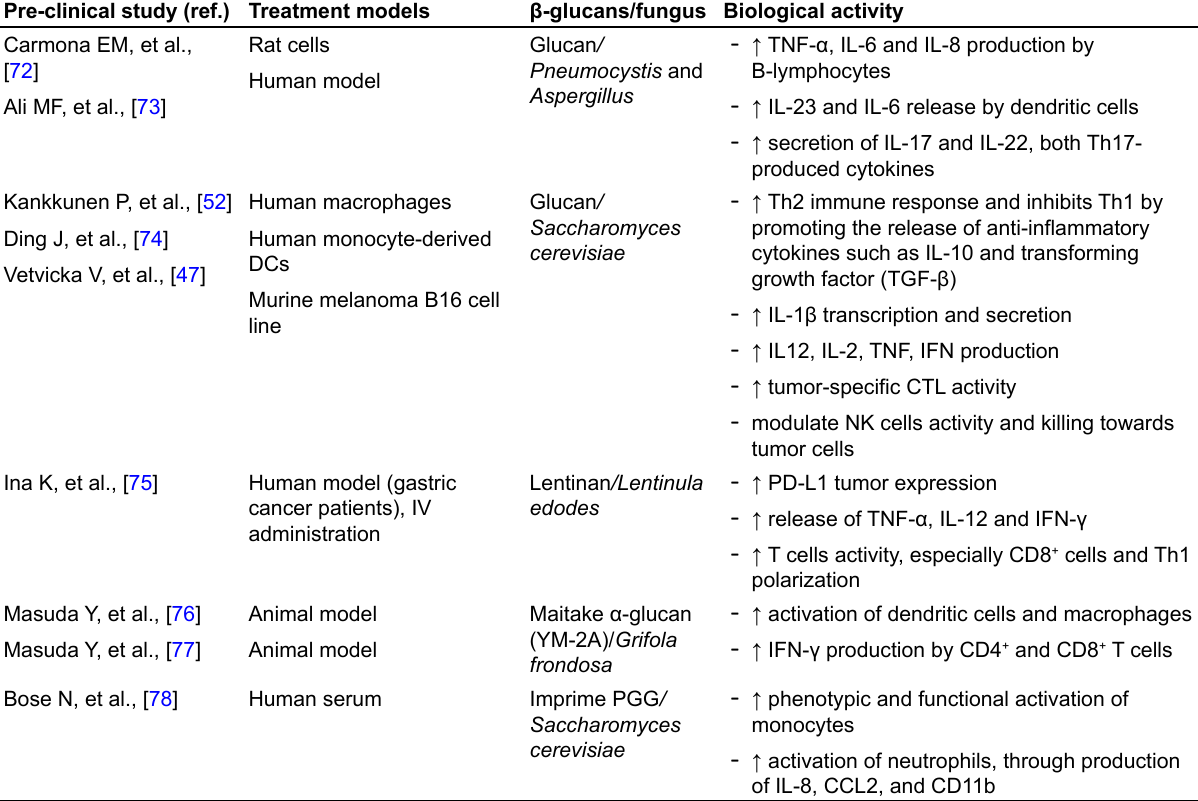
Table 1. Biological activity of most relevant β-glucans investigated in pre-clinical studies ( continued ) Pre-clinical study (ref.) Treatment models β-glucans/fungus Biological